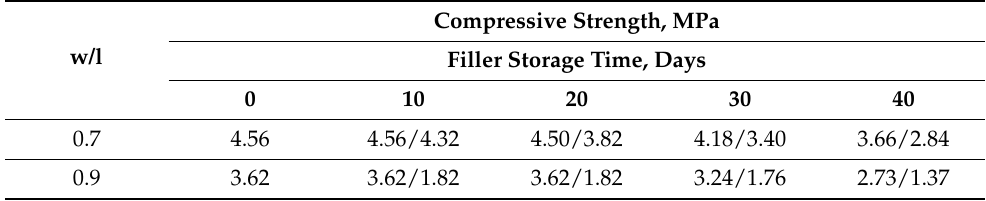
Table 9. Effect of storage conditions on the filler activity.